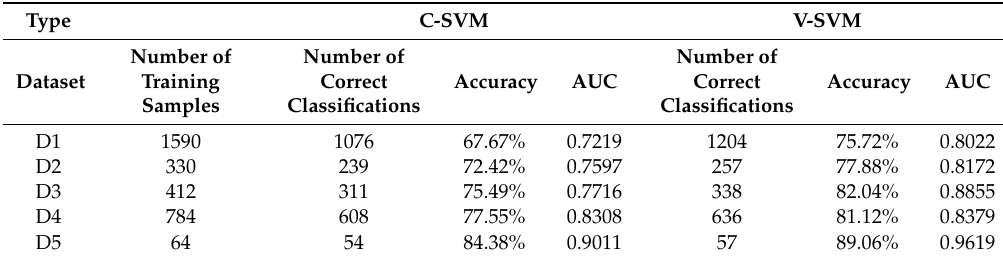
Table 3. Prediction performance of C-SVM and V-SVM for the testing dataset.